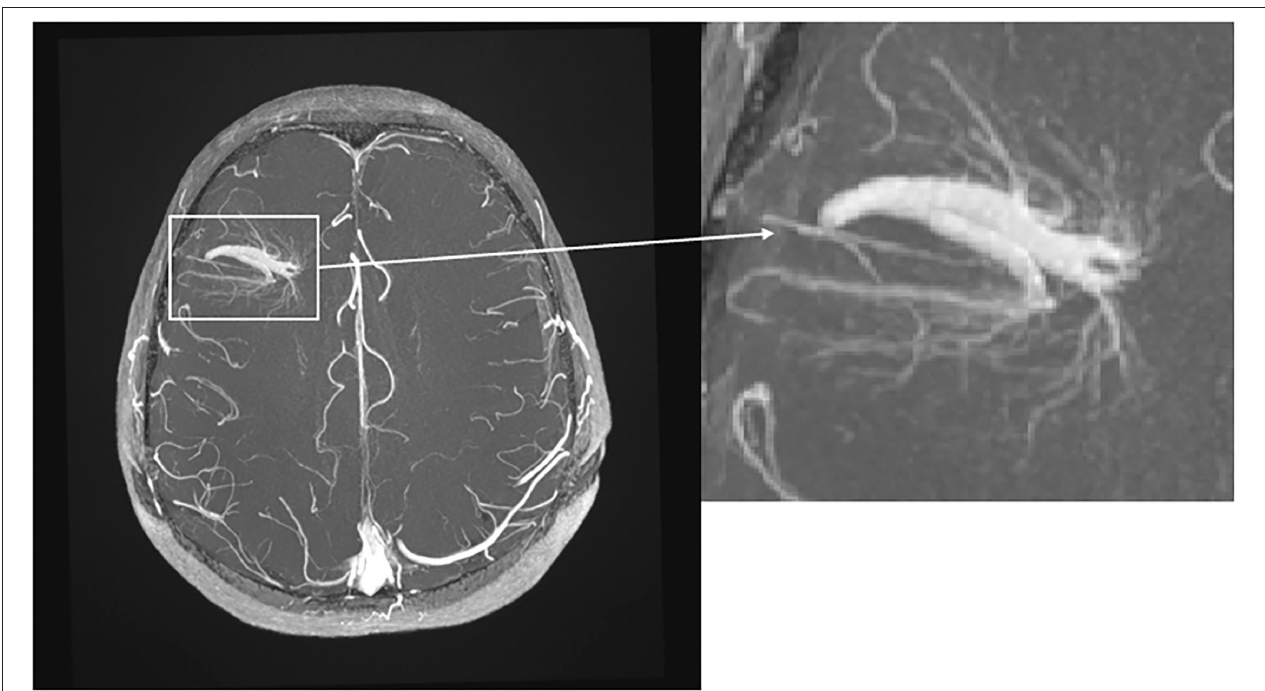
FIGURE 2 | Transverse T1-weighted TOF MRI with intravenous contrast. Note the big DVA with two collecting veins in the right frontal lobe with “umbrella sign.”